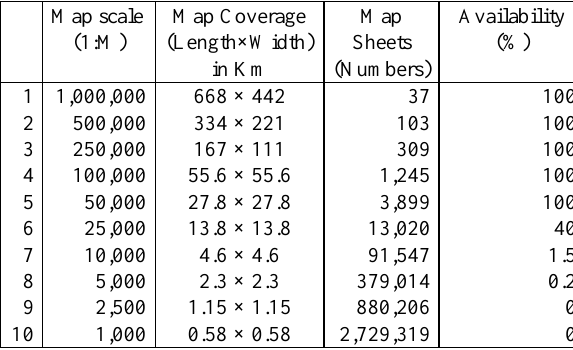
Table 1 Indonesian Topographical Maps Volume (2017)